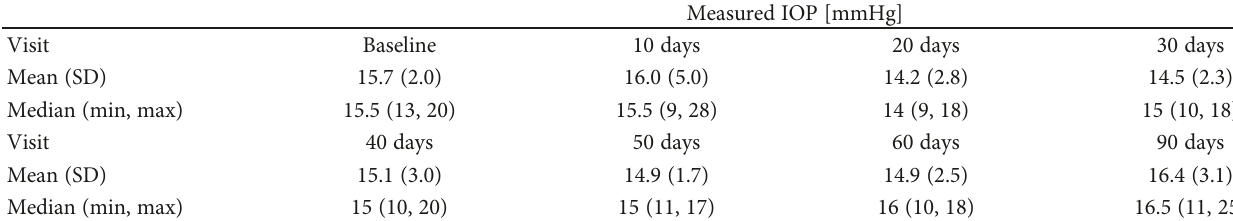
Table 4: Intraocular pressure (IOP) over